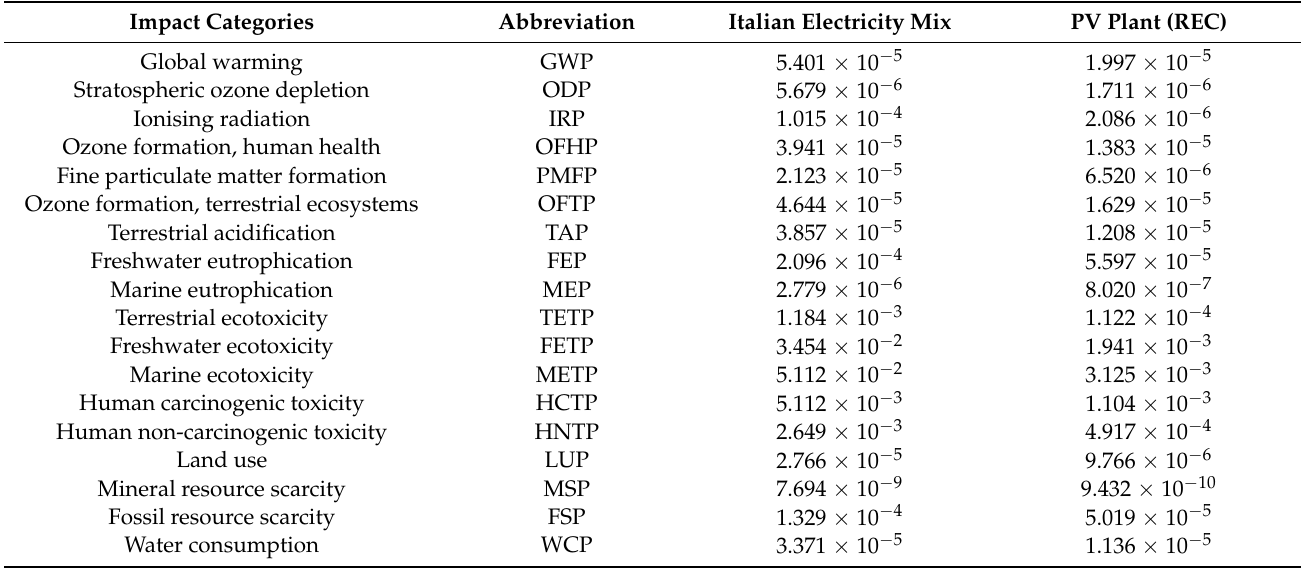
Table 5. Normalised impacts calculated for the evaluated PV plant compared to the Italian electricity mix (functional unit 1 kWh of electricity